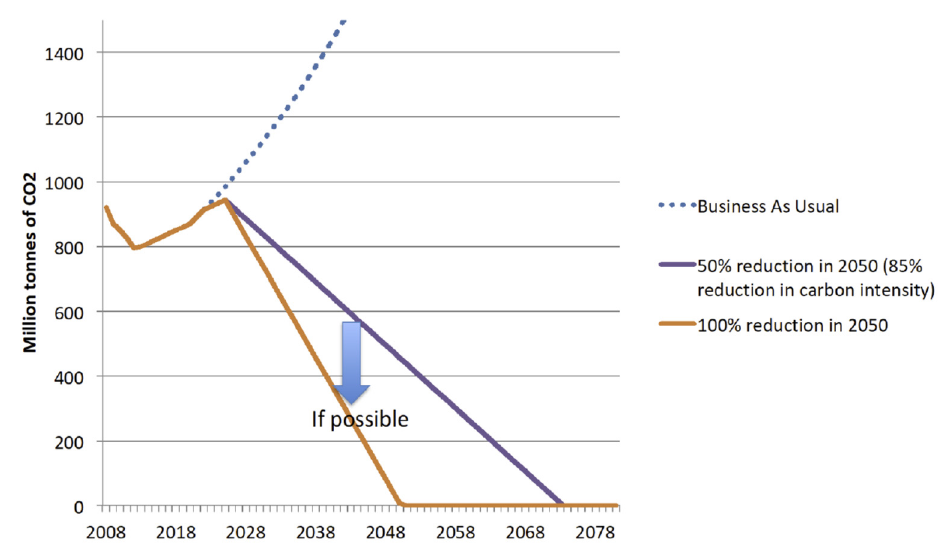
Figure 5. Projected pathways for the CO 2 emissions of the shipping industry. Source: [35]. The IMO Fourth GHG Study (2020) presents an updated marginal abatement cost curve (MACC) for the industry based on the likely means available for improving the energy efficiency or carbon intensity of the shipping industry: energy-saving technolo- gies; use of renewable energy; use of alternative fuels; and speed reduction. This updated industry MACC is shown in Figure 6. While it does account for all the planned changes to the EEDI regulations, it does not include the effect of the EEXI. On the basis of certain assumptions (particularly concerning the future prices of zero-carbon fuels), this updated MACC reveals that the objectives set within the IMO Initial Strategy are achievable, with approximately 64% of the total amount of CO 2 reduction contributed to by the use of al- ternative fuels.